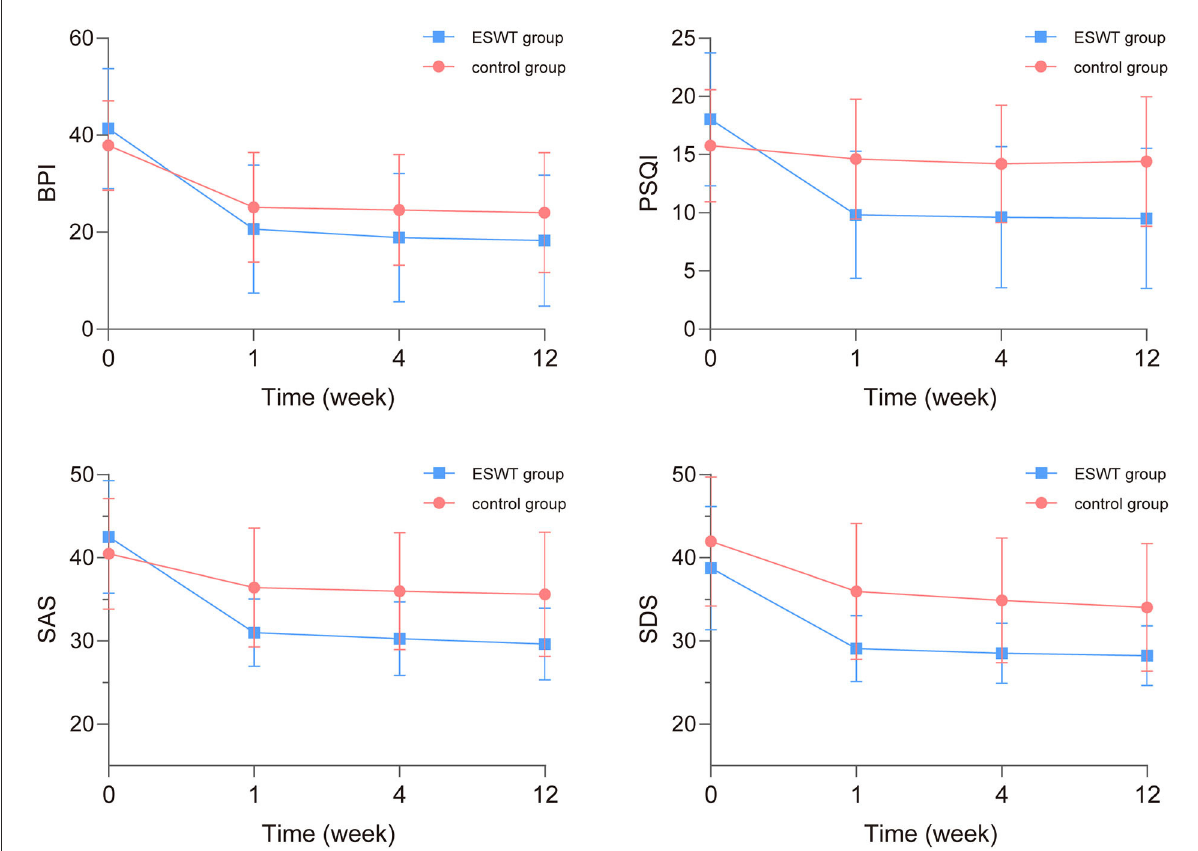
FIGURE4 The baseline and post-treatment brief pain inventory (BPI), self-rating anxiety scale (SAS), self-rating depression scale (SDS), and pittsburgh sleep quality index (PSQI) scores. The BPI, SAS, SDS, and PSQI scores in the ESWT group and the control group decreased over time while SDS scores in the ESWT group were statistically lower than the control